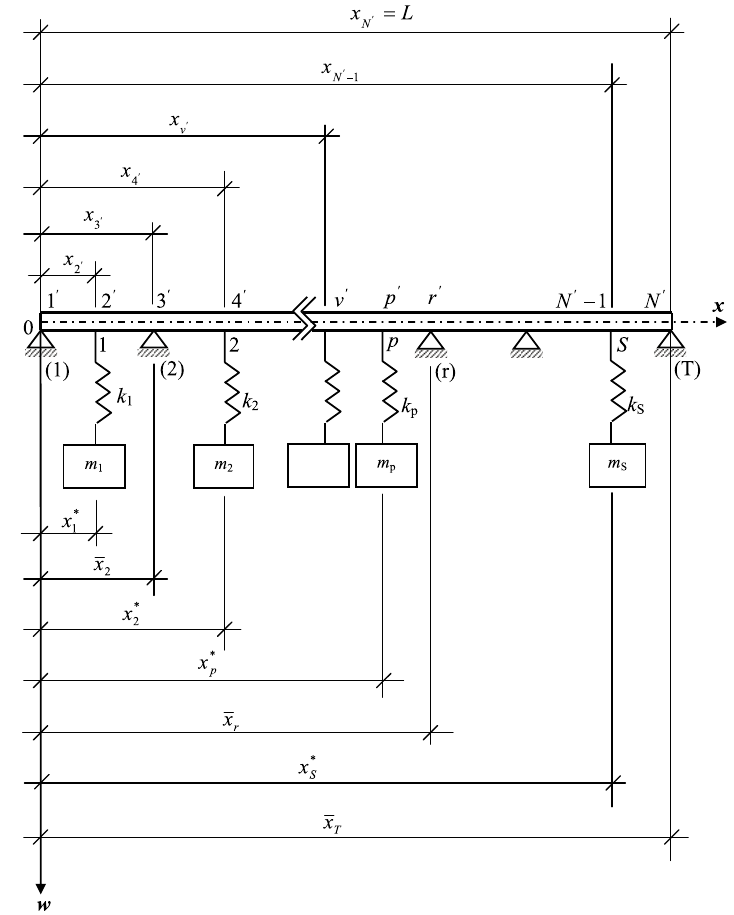
Fig. 2. A Reddy-Bickford uniform beam supported by T pins and carrying S spring-mass